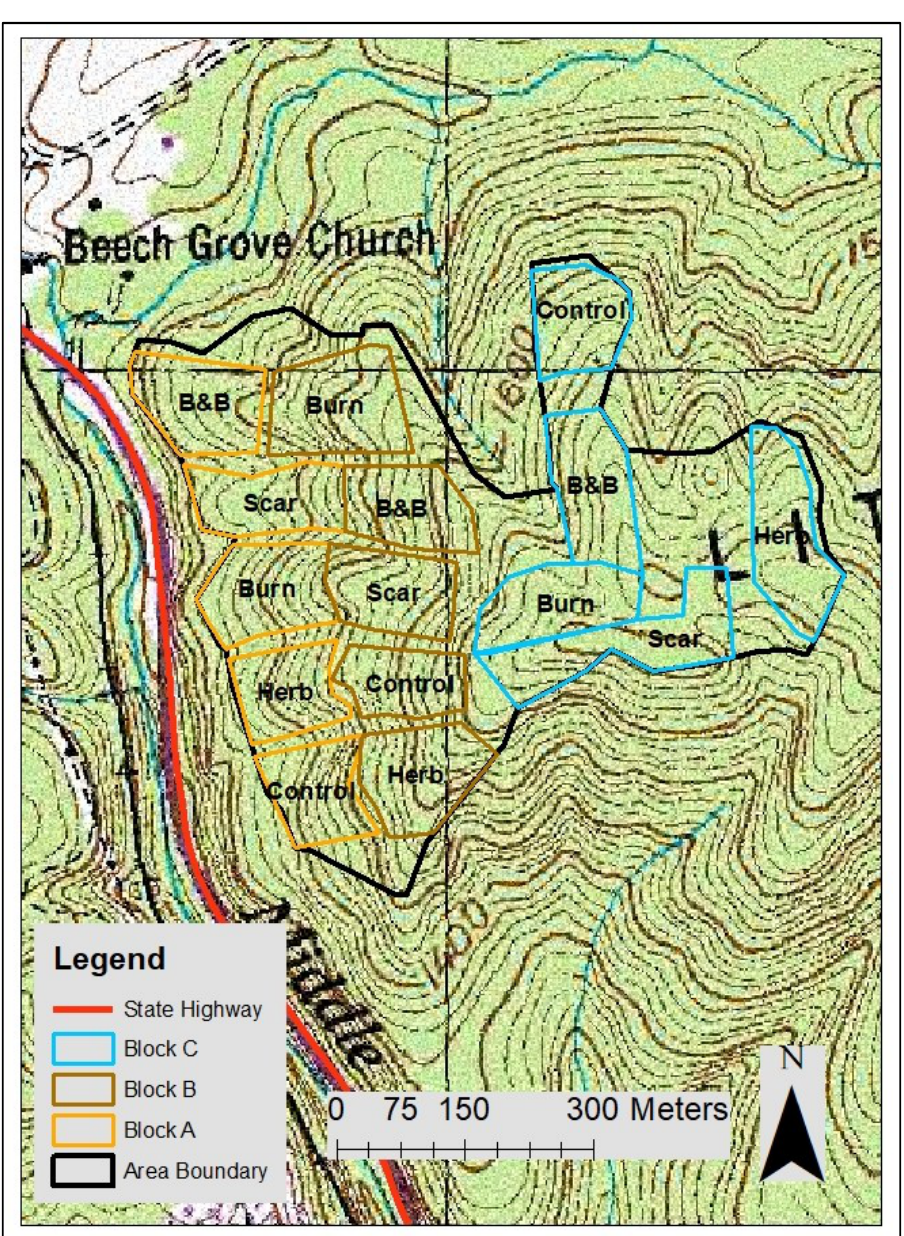
Figure 1. Study area boundary, block locations, and treatment assignments to experimental units are displayed over a Digital Raster Graphic topographic map of Morgan County, Tennessee, USA (courtesy of U.S. Geological Survey).